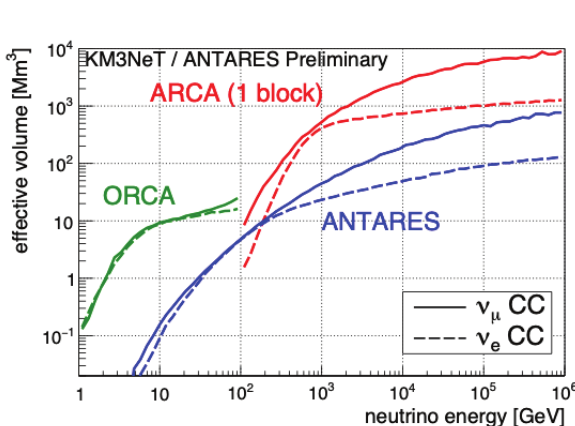
Figure 2: Detector e ff ective volumes as a function of neu- trino energy: comparison between ANTARES detector, ORCA and ARCA (1 building block). Solid lines refer to track event signatures ( ν μ charged coupled interactions) while dashed ones to shower signatures ( ν e charged cou- pled